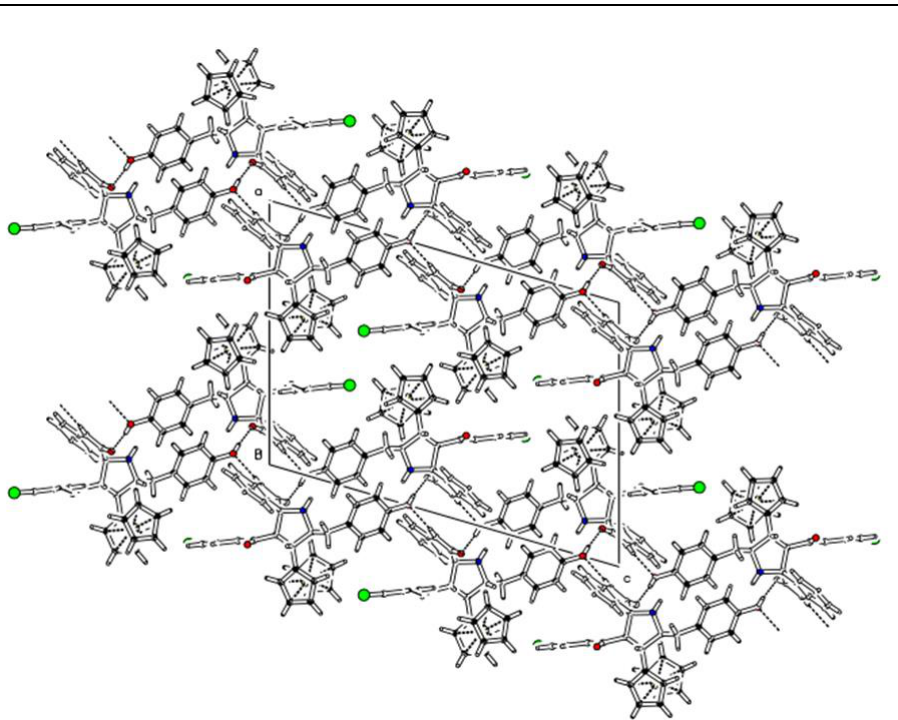
Figure 1. ORTERP diagram of 3a, where thermal ellipsoids were drawn at 40%.